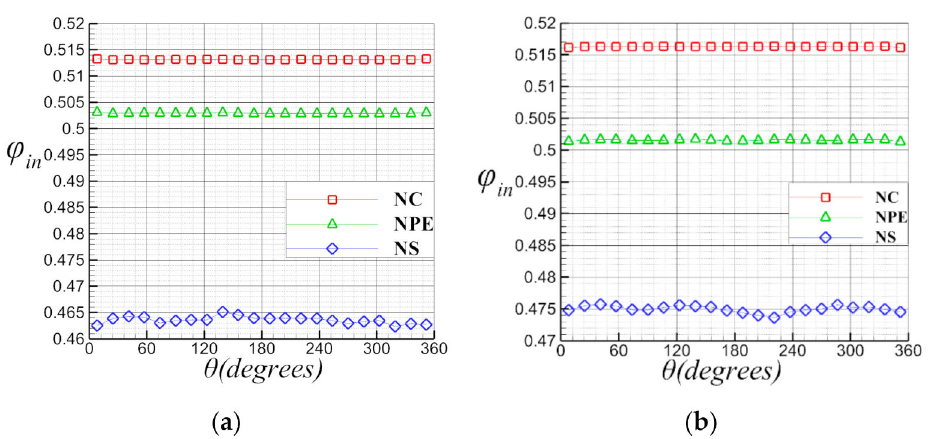
Figure 14. Distribution of inlet flow coe ffi cient along the circumference in the case of 0% eccentricity. ( a ) Steady CFD result; ( b ) unsteady CFD result.